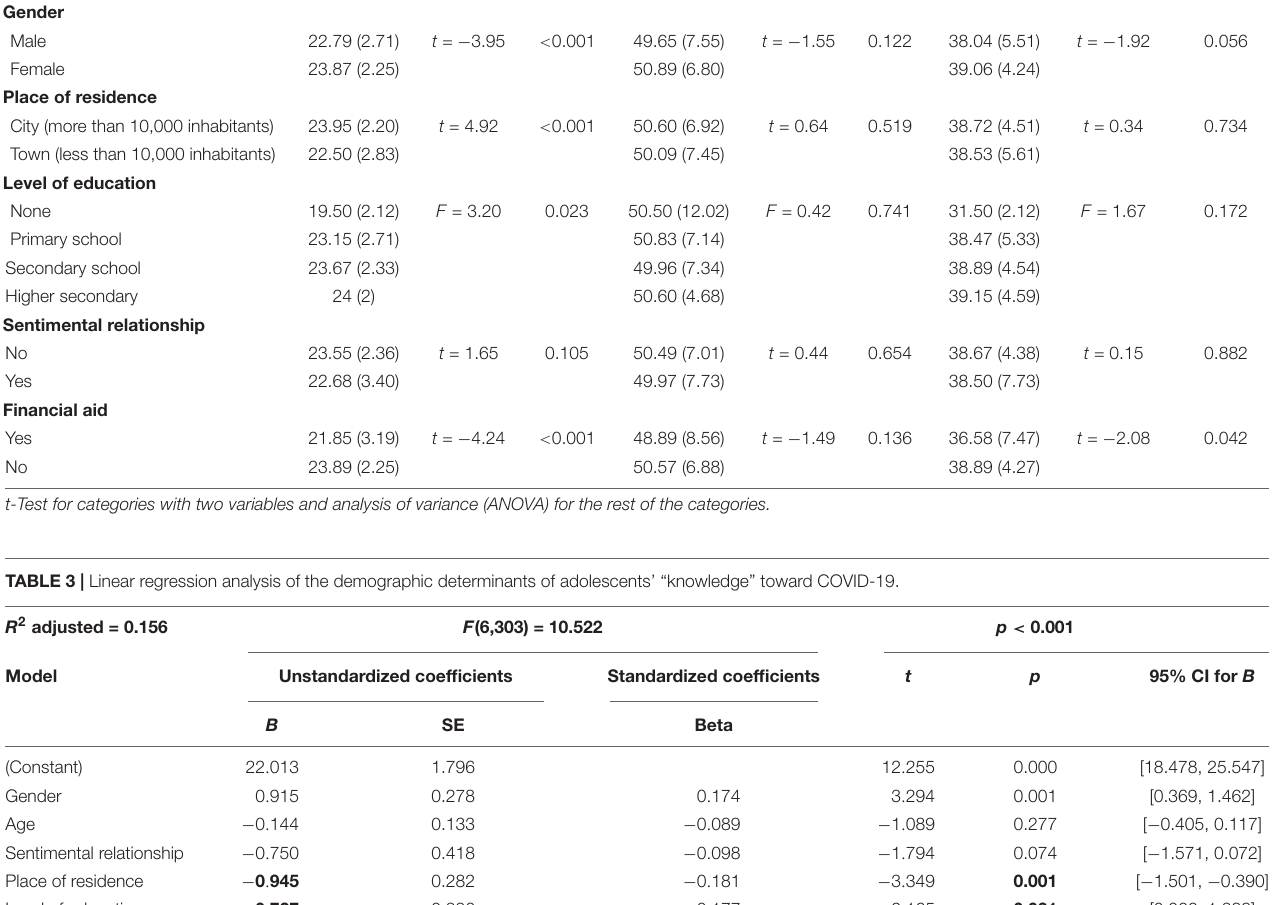
TABLE 2 | Univariable analysis.